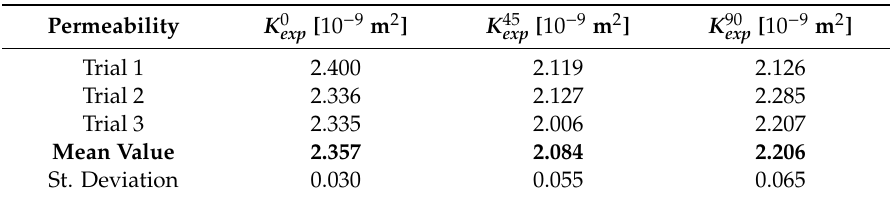
Table 4. Glass textile permeability measured in the tests.